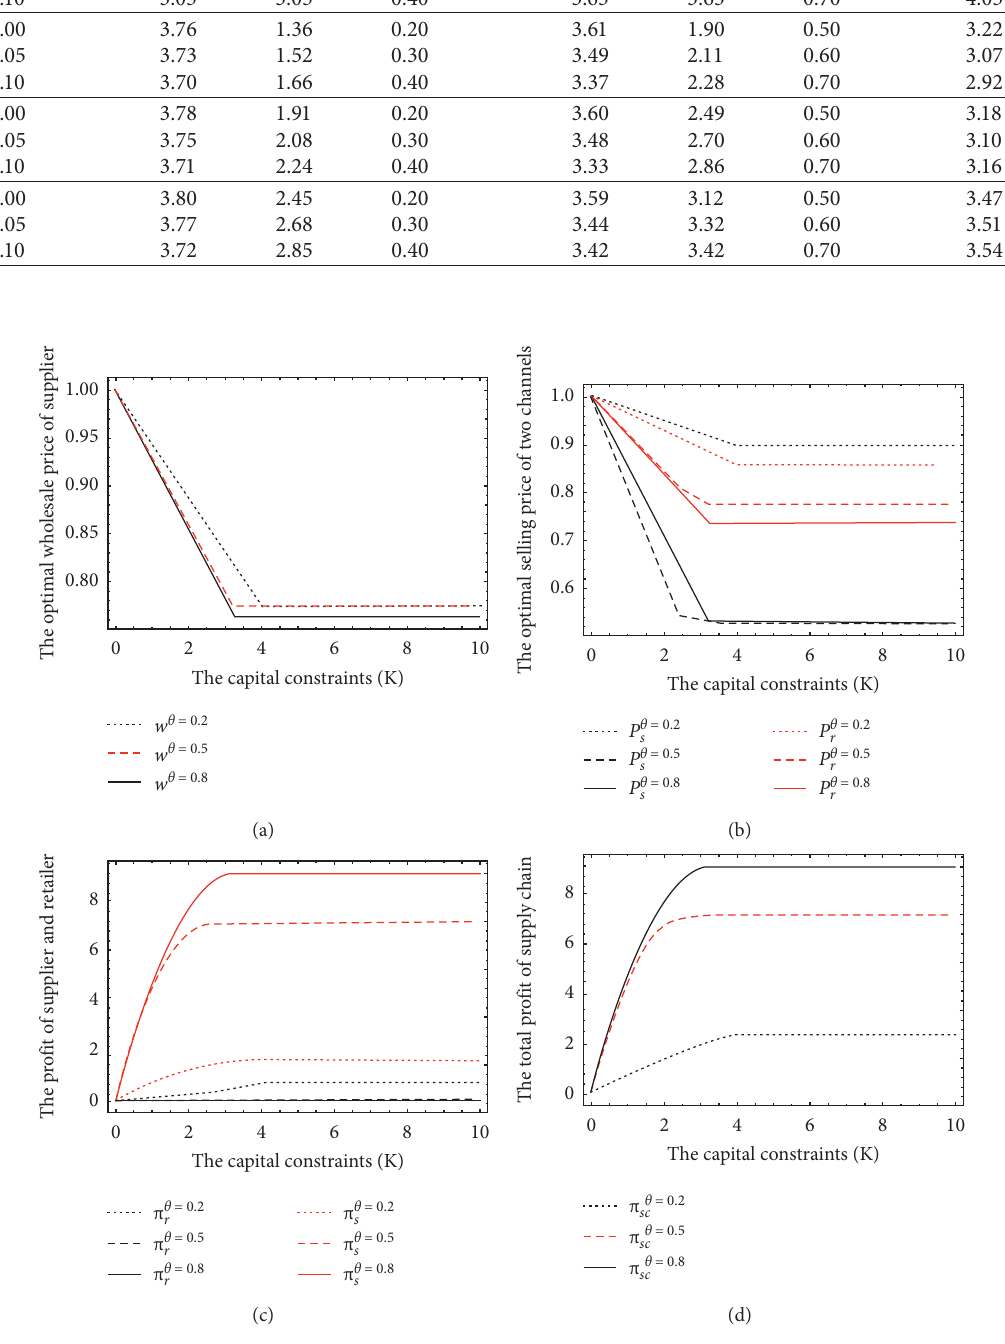
Figure 1: The impact of supplier’s capital on decisions and profits. (a) The impact of K on channel prices. (b) The impact of K on channel quantities. (c) The impact of K on channel profits. (d) The impact of K on supplier’s